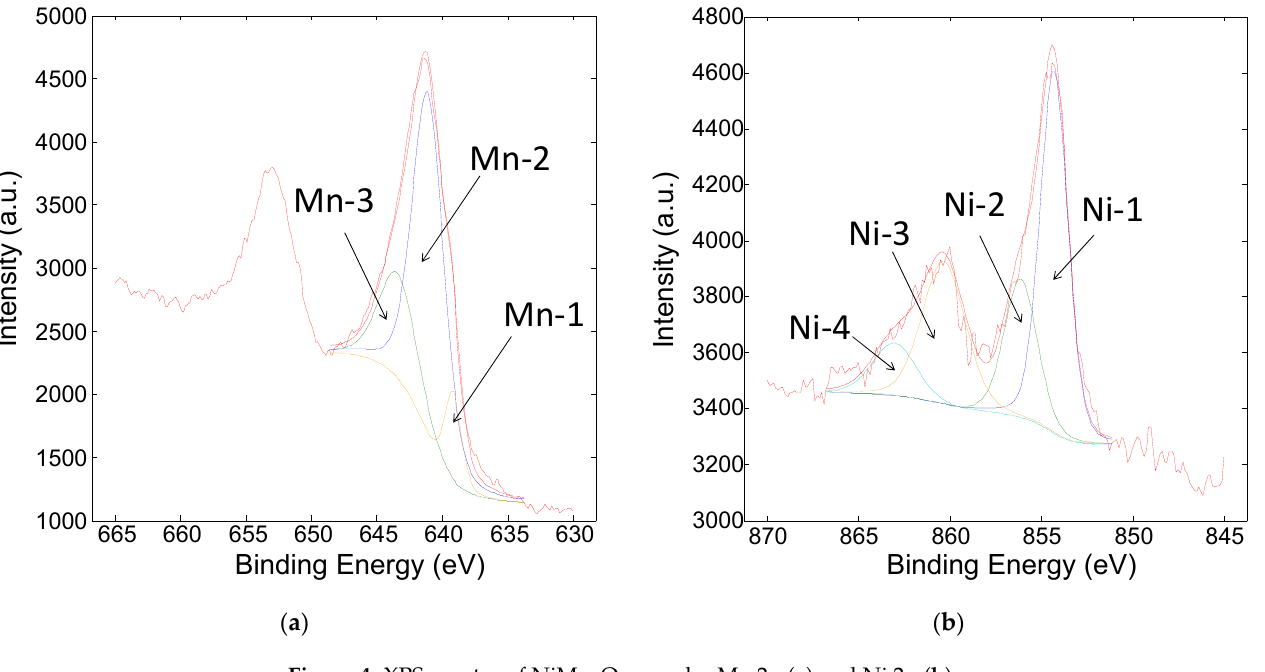
Figure 4. XPS spectra of NiMn 2 O 4 powder Mn 2p ( a ) and Ni 2p ( b ).